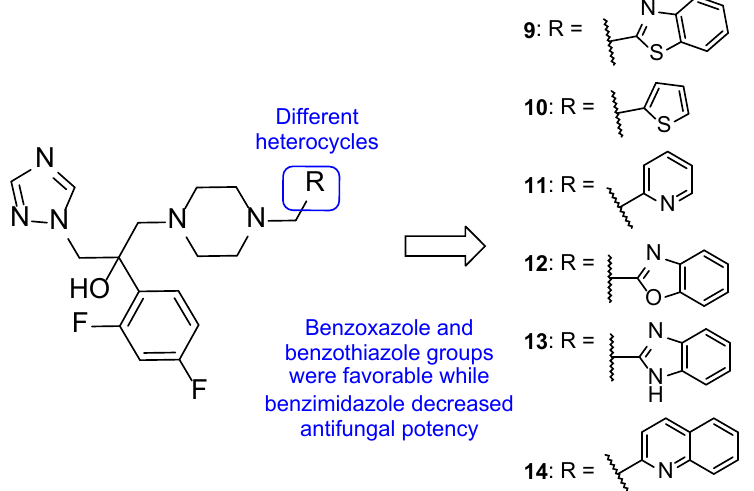
Figure 11. Chemical structures for compounds 9 – 14 , novel triazoles derived from albaconazole ( 8 ), and respective SAR [57] .